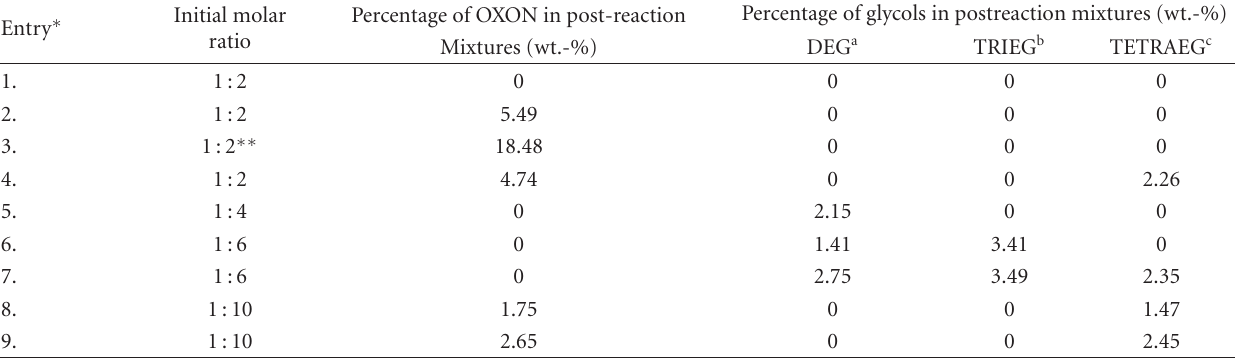
Table 2: Percentage of by-products in reaction products of BHEOA with excess of EC.